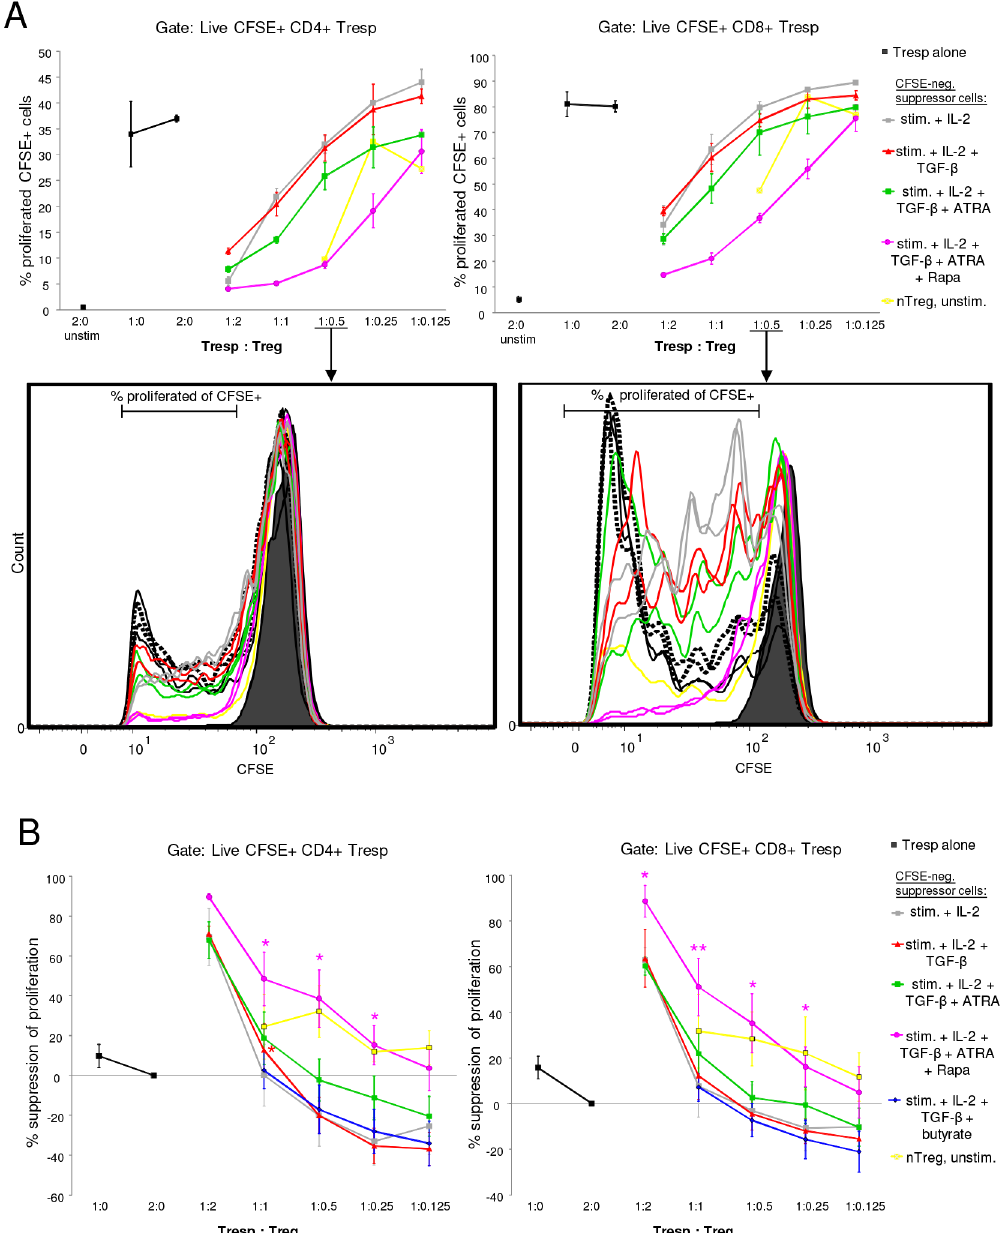
Fig 5. Comparative analysis of in vitro suppressive function of human iTregs generated with different iTreg-inducing protocols. iTregs were induced 6 days under the indicated conditions, washed, rested 2 days, washed again, and then used to analyze their suppressive capacity towards Tresp. Suppression assays with iTregs or control cells were performed with CFSE-labeled CD3+CD25- Tresp. Tresp and iTregs (or control stimulated mock suppressor cells, grey line) were cocultured at the indicated ratios, or Tresp cultured alone (black) in different densities. nTregs (yellow) were used as control. Cultures were stimulated for 4 to 5 days and then analyzed by FACS. (A) shows a representative donor. It was gated on CFSE+ CD4+ Tresp (left panel) or CFSE+CD8+ Tresp (right panel). The upper plots show mean +/- SD of wells plated in replicate. The lower panel shows overlays of CFSE histograms for the 1:0.5 ratio. Unstim. = unstimulated; others are stimulated for 5 days with pb anti-CD3 and soluble anti-CD28 antibodies. Dotted black lines = 2:0 Tresp, solid black lines = 1:0 Tresp, filled histogram = unstimulated Tresp. Lines in same color represent cells plated in replicate wells. The gate for determining the percentage of proliferated cells is indicated by the horizontal line. (B) Shows percent suppression calculated from CFSE proliferation as in (A), with 2:0 Tresp set to 100% proliferation (0% suppression). Shown is the compiled data (mean +/- SEM) for n = 2 to 6 donors (n = 2 for 1:2 ratio; n = 4 for “ butyrate ” iTreg, all other iTregs: n = 6 donors). Significance was calculated by paired t test, comparing suppression by iTreg populations to mock suppressor cells (stimulated with anti-CD3/-CD28 and IL-2 only; grey line) within each donor at 1:1; 1:0.5 or 1:0.25 cell ratios. Asterisks indicate significant differences and are depicted in the color of the respective iTreg condition. * : p < 0.05; ** : p < 0.01.